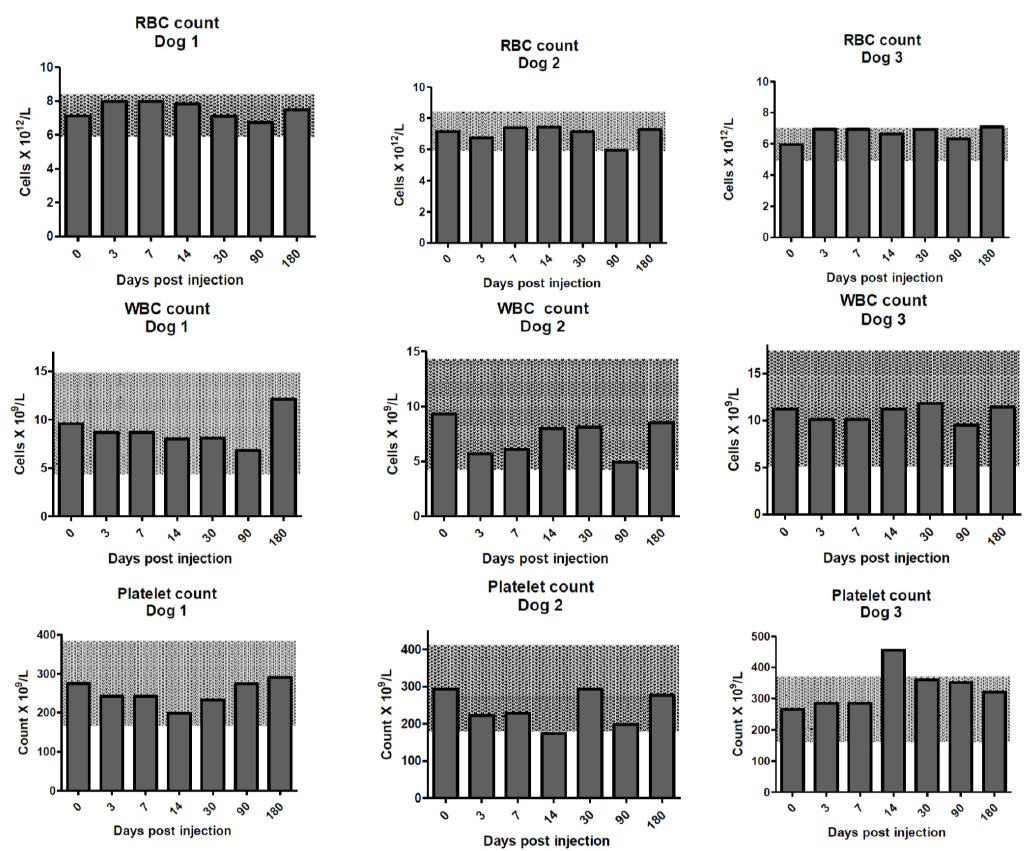
Figure 1. Red blood cell (RBC) counts (upper row), white blood cell (WBC) counts (middle row), and platelet counts (lower row) for the dogs on days 0–180 post treatment with 213 Bi-400-2 antibody. Shaded areas show reference change values (RCVs).